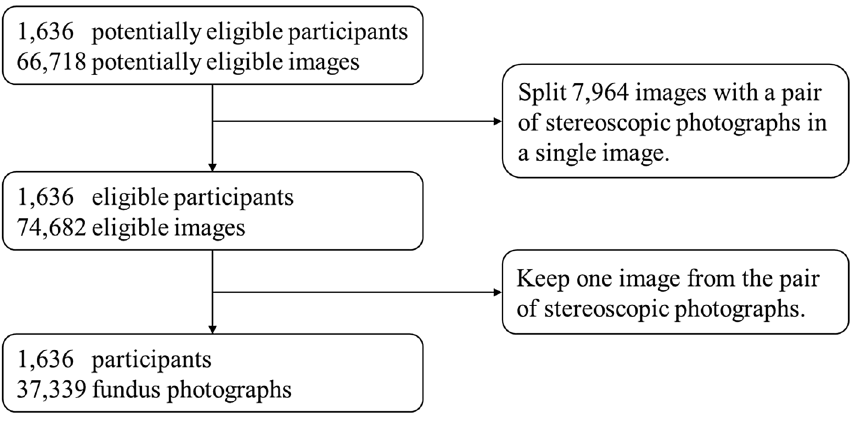
Figure 1. Creation of the OHTS